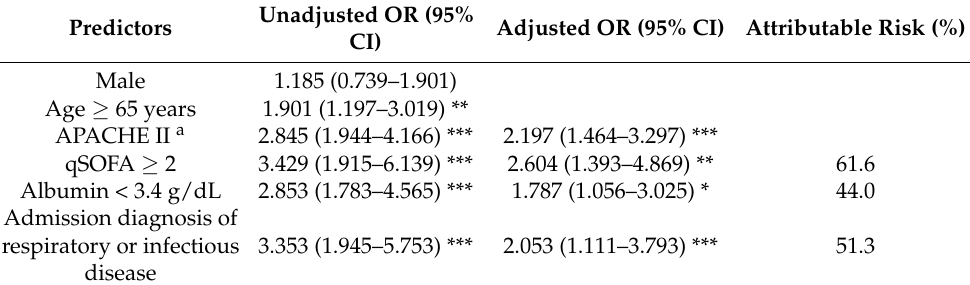
Table 2. Univariate and multivariate regression analyses to identify predictors for